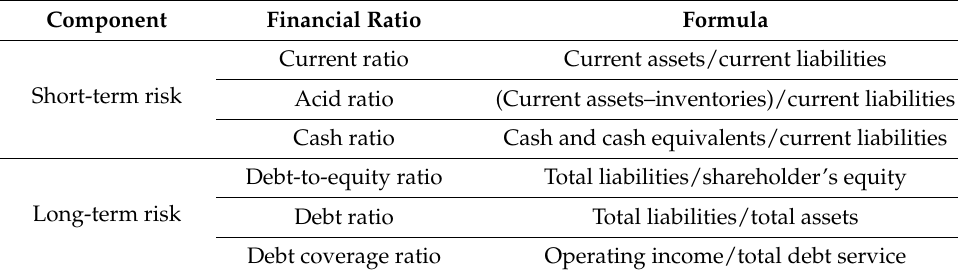
Table 3. Calculation of financial ratios related to short- and long-term risks.